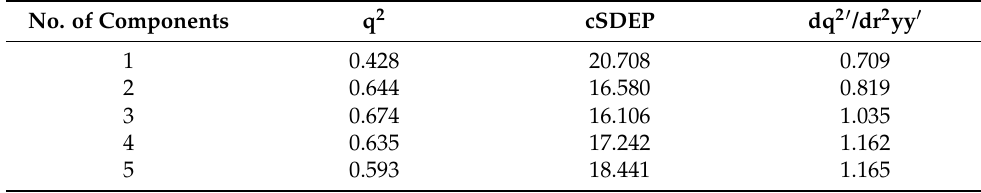
Table 3. Summary of progressive scrambling stability test for the CoMSIA